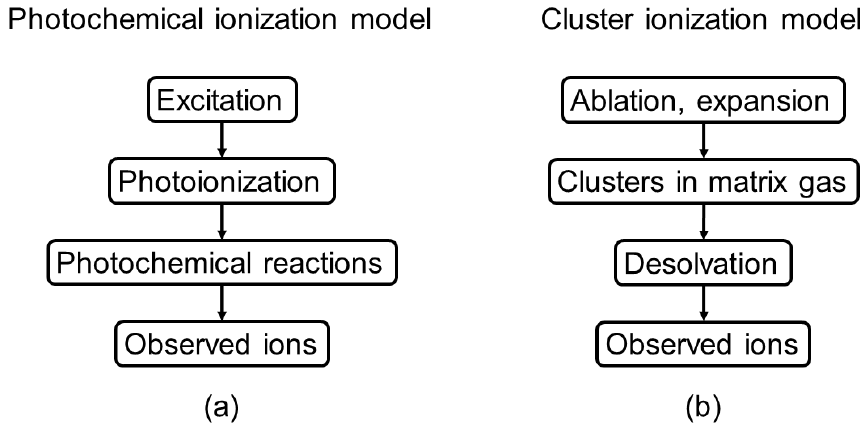
Figure 1. ( a ) Schematic diagram of photoionization and subsequent reaction pathways in matrix- assisted laser desorption/ionization mass spectrometry (MALDI)-MS, as proposed by Ehring, Karas, and Hillenkamp in 1992 (see the literature [8] for further details). ( b ) Sketch of the major processes proposed in the cluster models of MALDI ionization, as proposed and largely developed by the Karas group (see the literature [22] for further details).